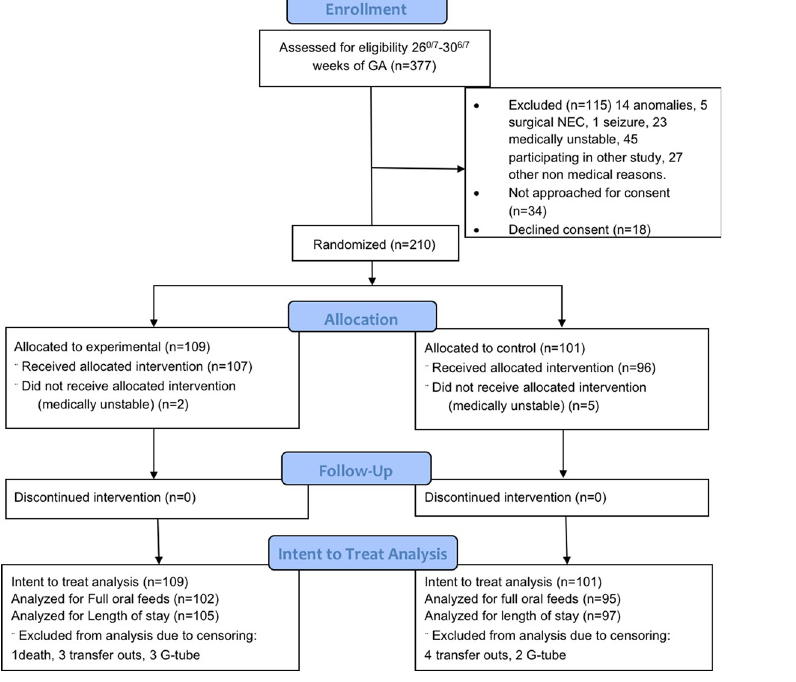
Fig 1. CONSORT flowchart—study subject eligibility and